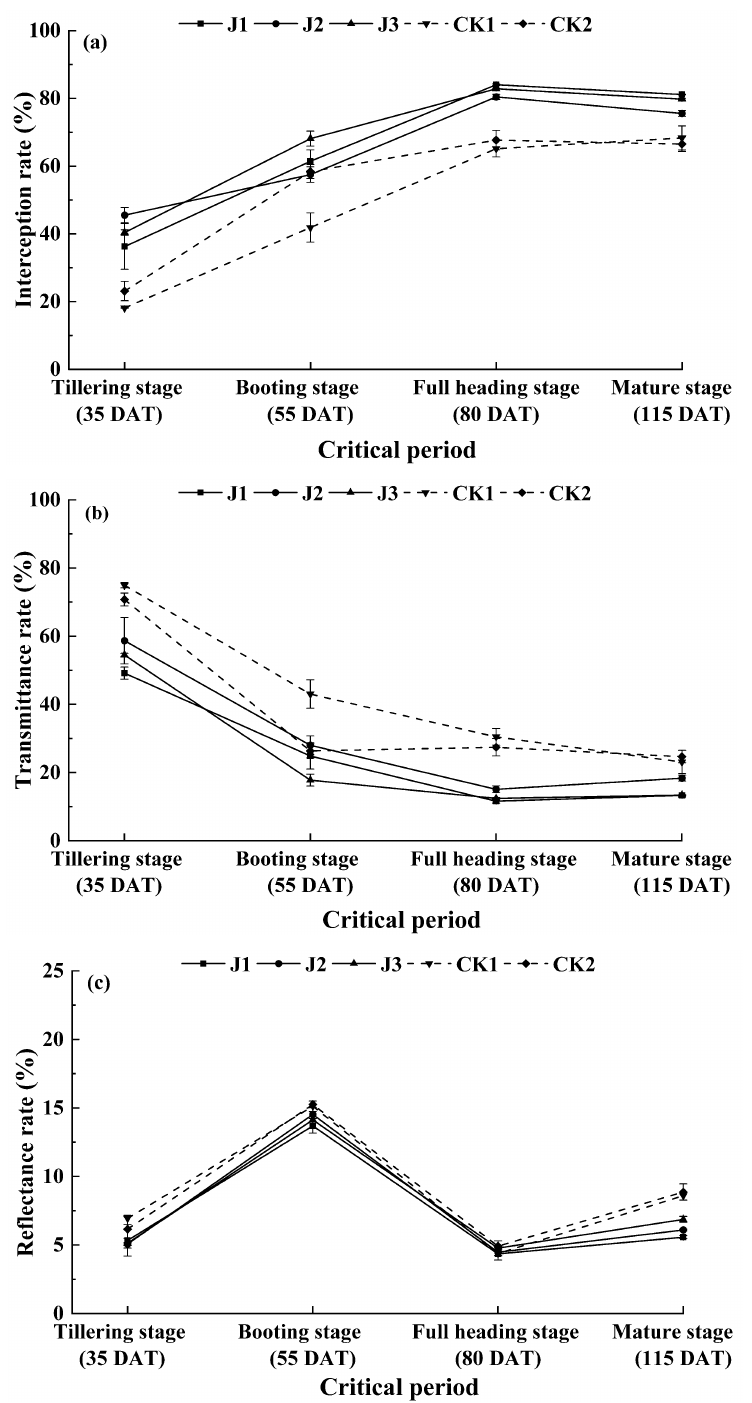
Figure 3. Canopy light interception rate ( a ); transmittance rate ( b ) and reflectance rate ( c ) of rice under the applied fertilization methods. The error bars show the standard error ( n = 3).